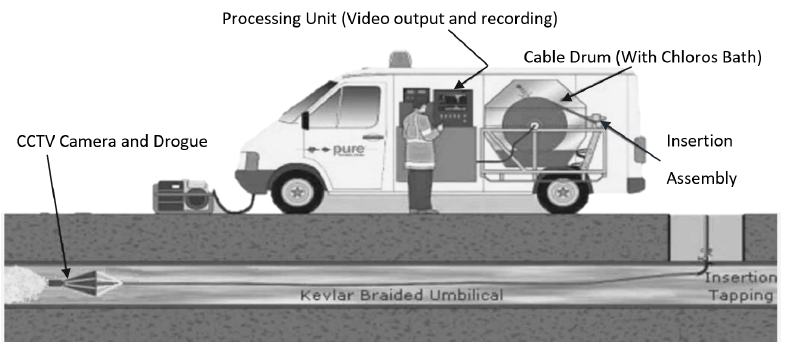
Figure 2. Illustration of Sahara System that utilizes the use of the CCTV camera in detecting pipe leaks